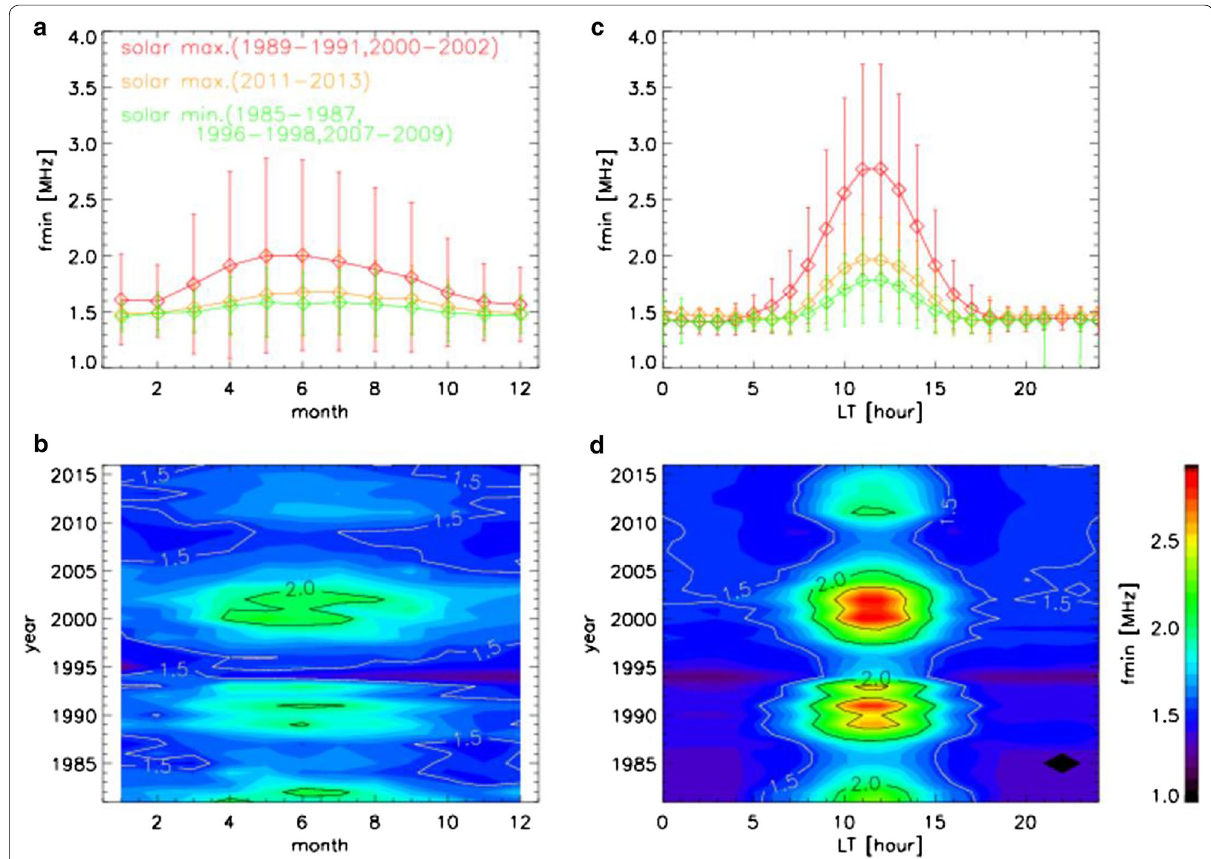
Fig. 2 a Seasonal variation in monthly averaged f min as a function of month, b contour map of monthly averaged f min values in MHz as a function of month and year, c averaged f min as a function of LT ( UT 9 h), and d contour map of f min values in MHz as a function of LT and year. Vertical = + lines in a, c show the standard deviation, 1 σ , and line colors distinguish the solar minima and two groups of solar maxima, as labeled in ±